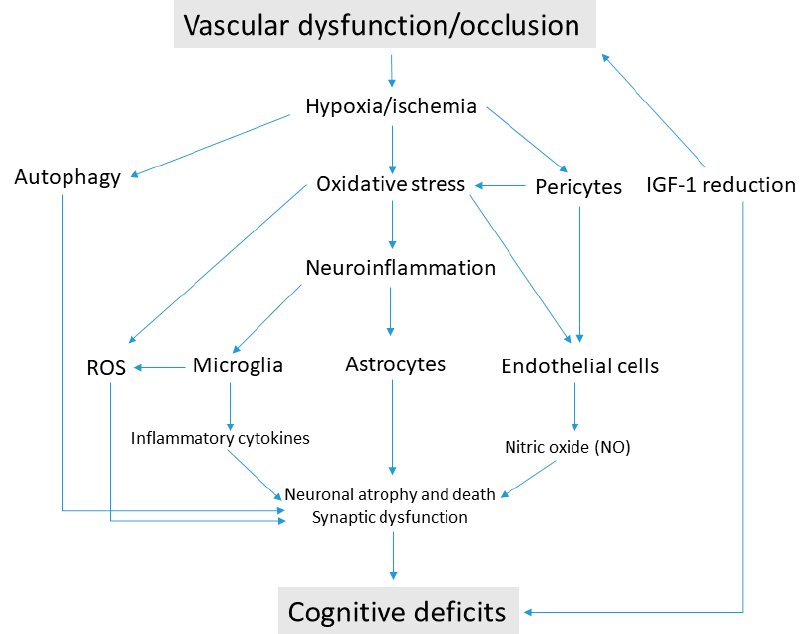
Figure 1. Pathogenic mechanisms causing cognitive deficits in vascular cognitive impairment. Vascular dysfunction / occlusion induces a state of hypoxia / ischemia at the neurovascular unit. The consequent oxidative stress triggers the production of reactive oxygen species (ROS) and sustains the process of neuroinflammation in glial cells. Microglia activation produce proinflammatory cytokines and destruction of astrocyte endfeet contribute to disrupting cytoarchitecture in brain regions involved in cognitive function. Hypoxia / ischemia is also responsible for the loss of pericytes, which cause blood–brain barrier (BBB) and endothelial cell dysfunction. Endothelial cells damaged by oxidative stress cause reduced release of nitric oxide (NO), while excessive autophagy contributes to neuronal damage. The age-related decline of insulin-like growth factor-1 (IGF-1) may be the cause of vascular pathologies from one side, and it may impair synaptic activity from the other side, thus generating cognitive deficits.